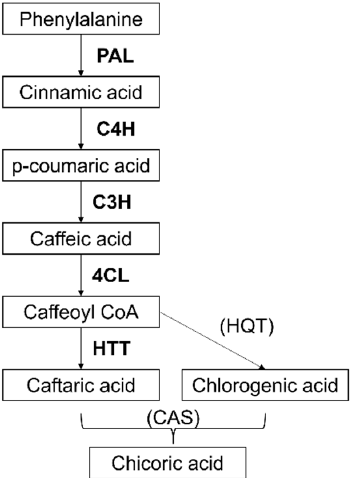
Figure 3. Simplified biosynthetic pathway of chicoric acid. The enzymes involved in each step are reported with their acronym in bold and their encoding genes were analyzed in this study, with the only exception of HQT and CAS (between bracket). Abbr: PAL—phenylalanine ammonia-lyase;